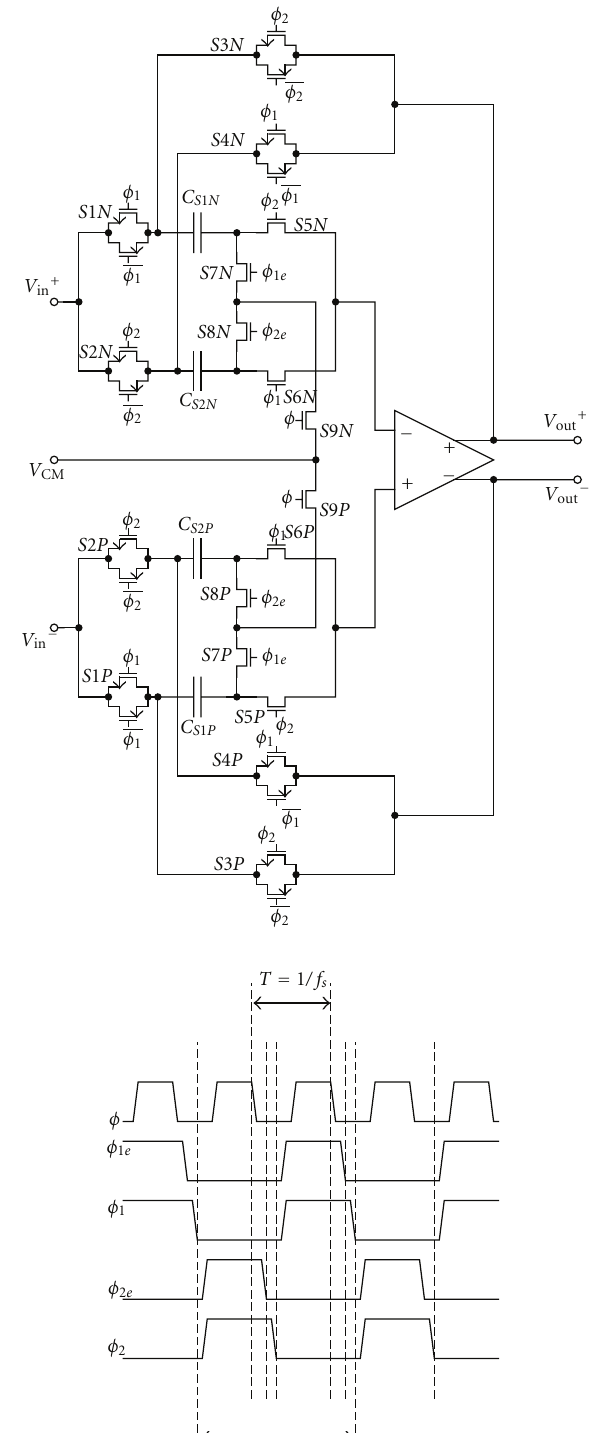
Figure 6: SC-S&H block